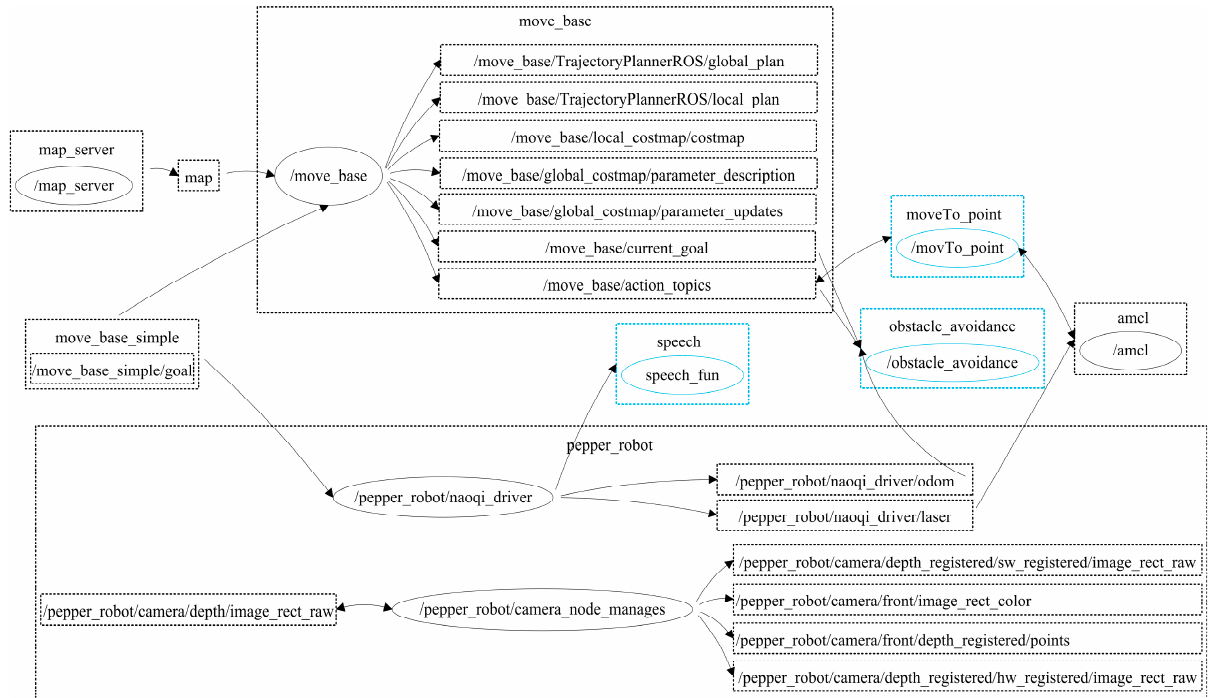
Figure 2. The architecture of the developed ROS-based navigation framework. Table 2. A summary of the developed navigation functions.